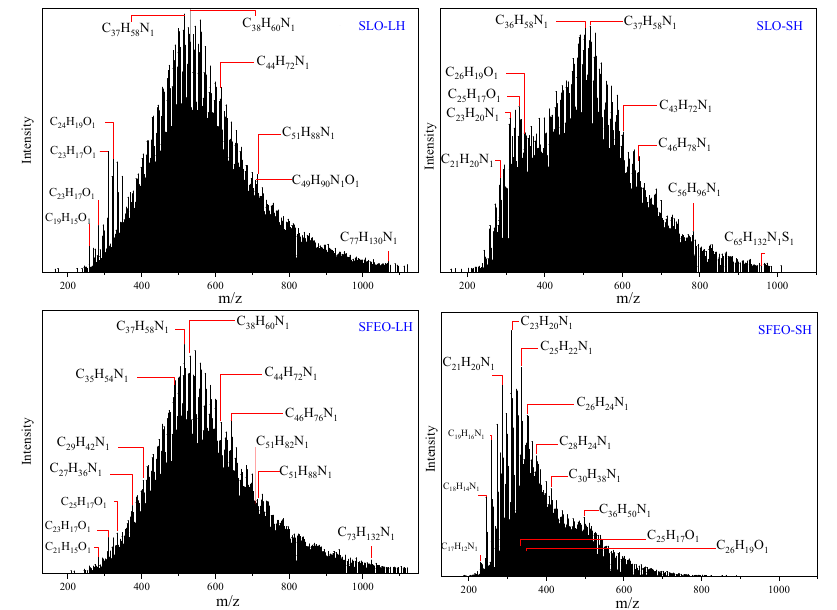
Figure 9. Mass spectra of SLO and SFEO were obtained by FT-ICR MS. (+ESI).